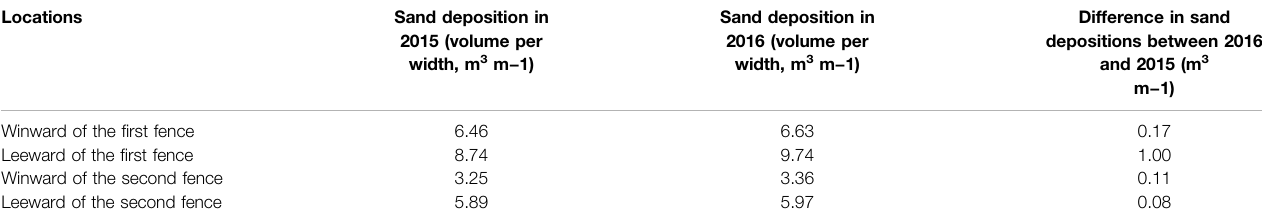
TABLE 2 | Volume of deposited sand on the windward and leeward sides of the fi rst and second concrete plate-insert sand fences (CPISFs) in 2015 and 2016.